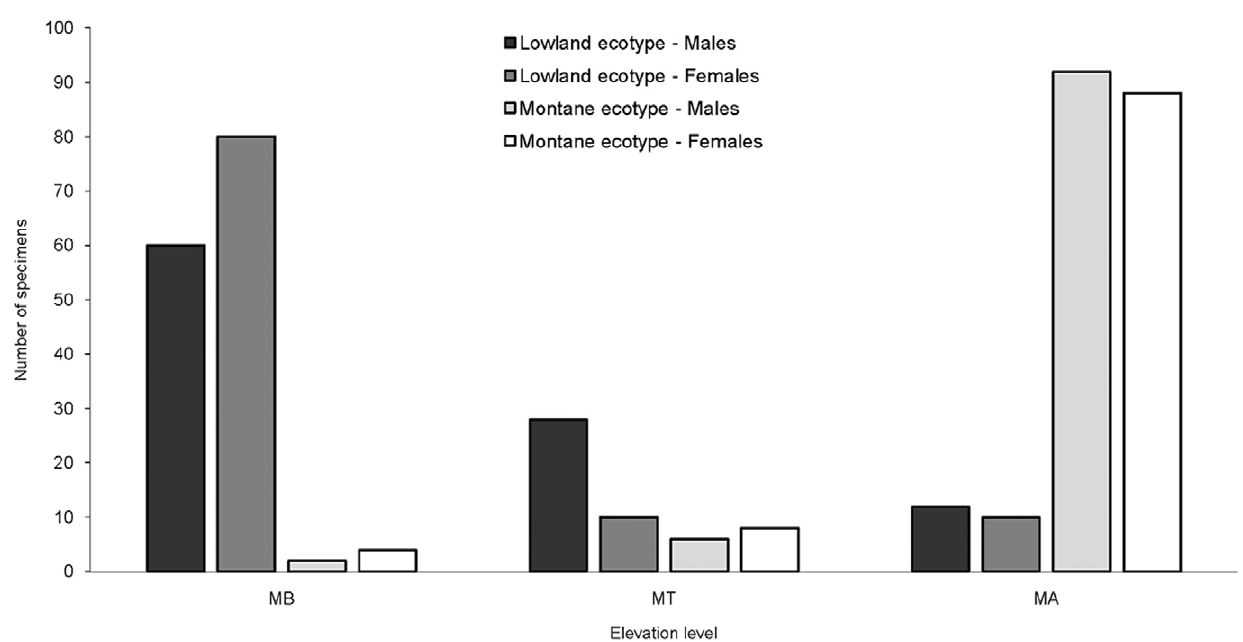
Figure 3. Location of Agabusbipustulatus ecotypes in relation to sampled area and elevation in northern Sweden. Morphological data were generated from spatial covariation of homologous landmarks that calculate affine ( partial warps ) and nonaffine ( uniform ) shape components as described by Bookstein [48]. Dispersal patterns implied via a reclassification model following a discriminate function analysis (DFA) of the shape parameters are as follows: Lowland ecotype – Male ( & ); Lowland ecotype – Female ( ); Montane ecotype – Male ( ); Montane ecotype – Female ( % ).